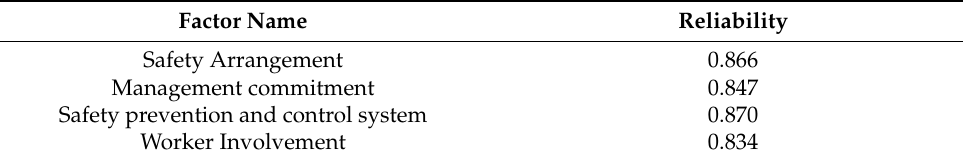
Table 4. Reliability Analysis.